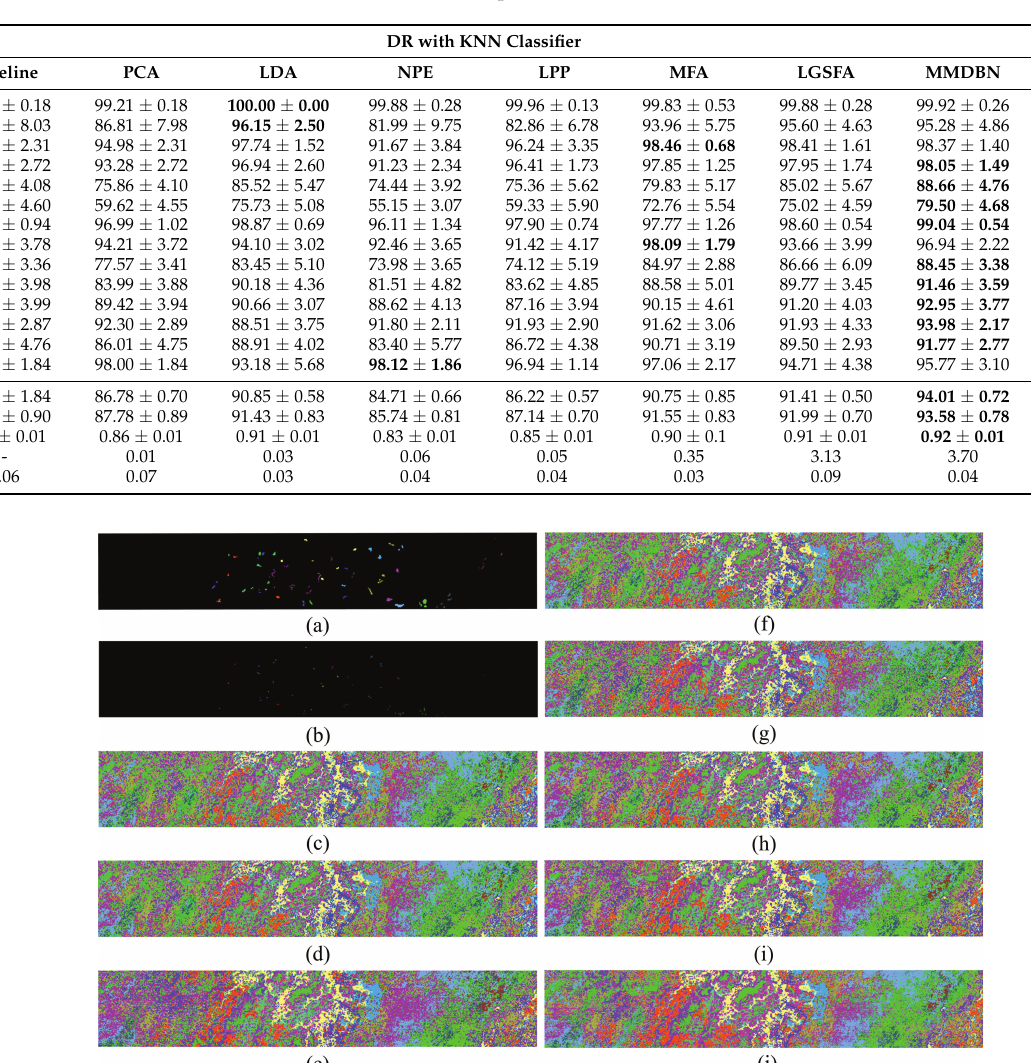
Table 6. Classification results of each class samples via different DR methods for Botswana dataset (%).